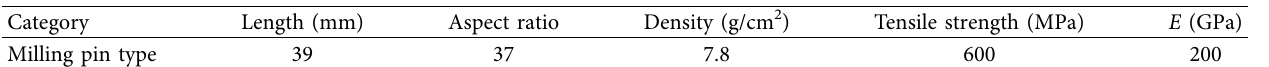
Table 3: Steel fiber properties.